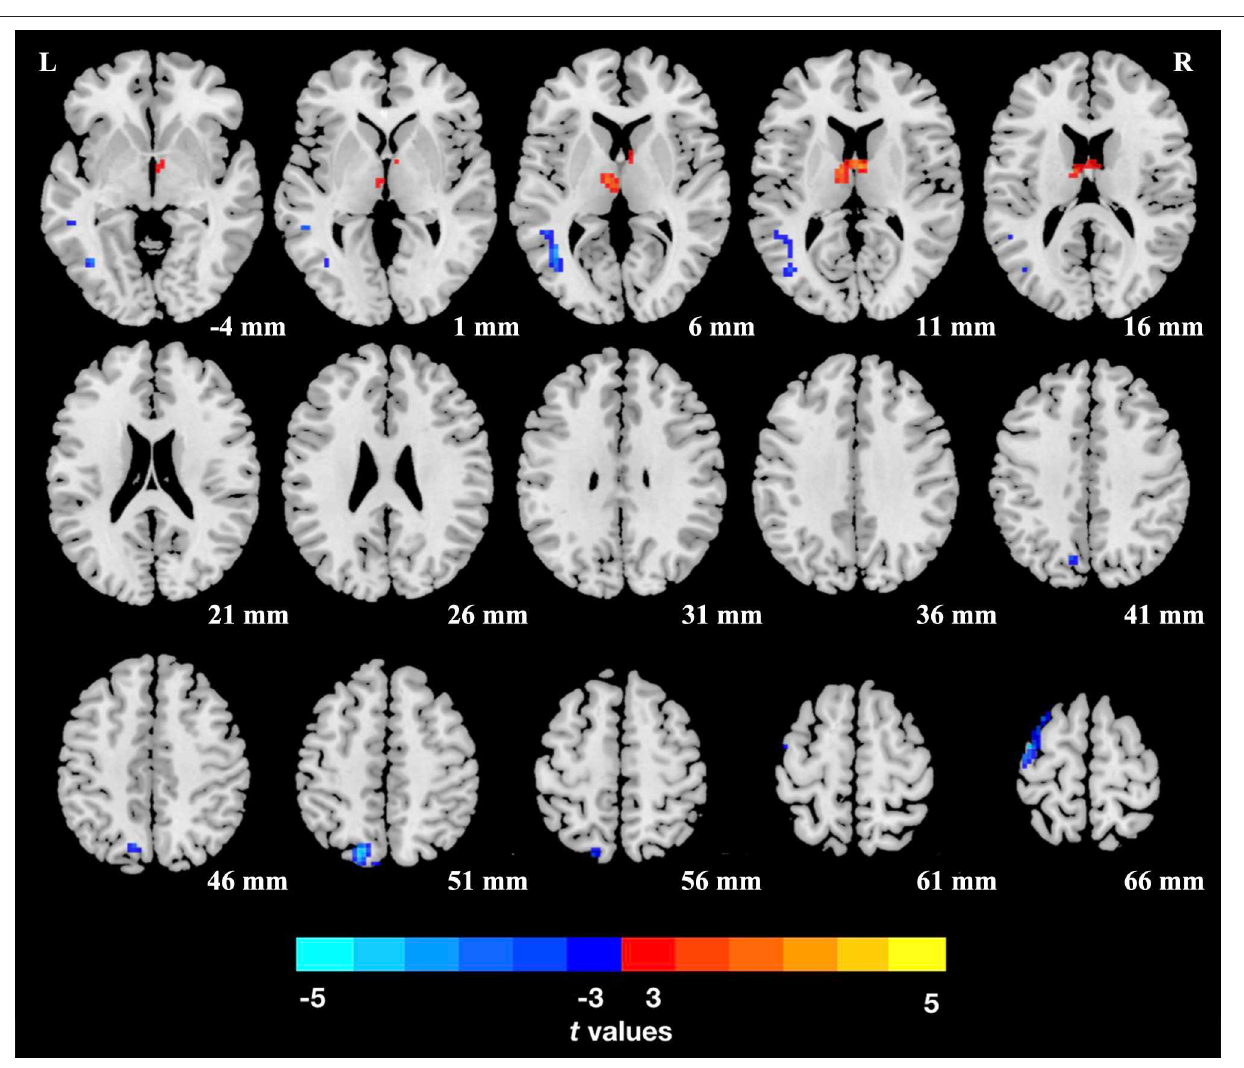
second level of the pain-information-processing circuit that supports the active, conscious, and cognitive assessment of pain perception